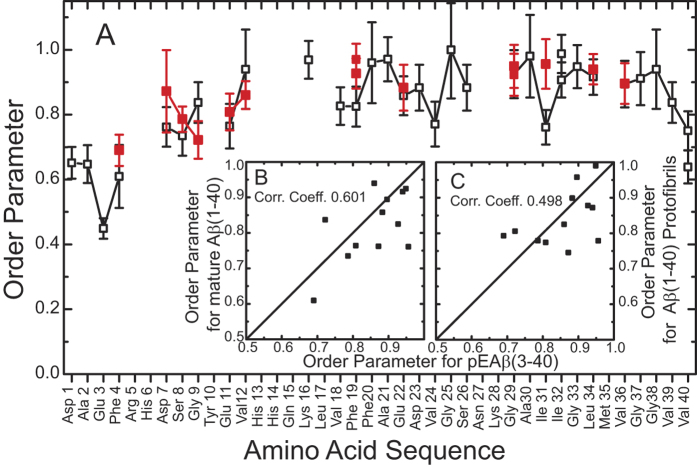
(A) Comparison of the 13Cα-1H order parameters of pGlu3-Aβ(3–40) (red) and mature Aβ(1–40) (black) fibrils21. Correlation plots of the 13Cα-1H order parameters of pGlu3-Aβ(3–40) with (B) mature Aβ(1–40)21 and (C) with Aβ(1–40) protofibrils35 are shown as insets. The Pearson correlation coefficient is given for both correlation plots.